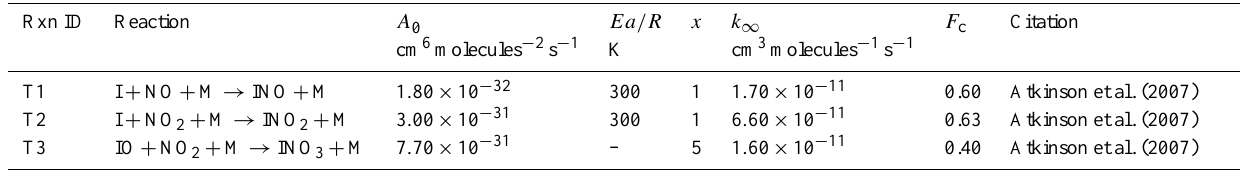
Table 4. Termolecular iodine reactions. The lower pressure limit rate ( k 0 ) is given by: A 0 · exp ( Ea by k ∞ . F c characterizes the fall-off curve of the reaction as described by Atkinson et al. (2007). Unknown values are represented by a dash and these set to zero in the model, reducing the exponent to 1.